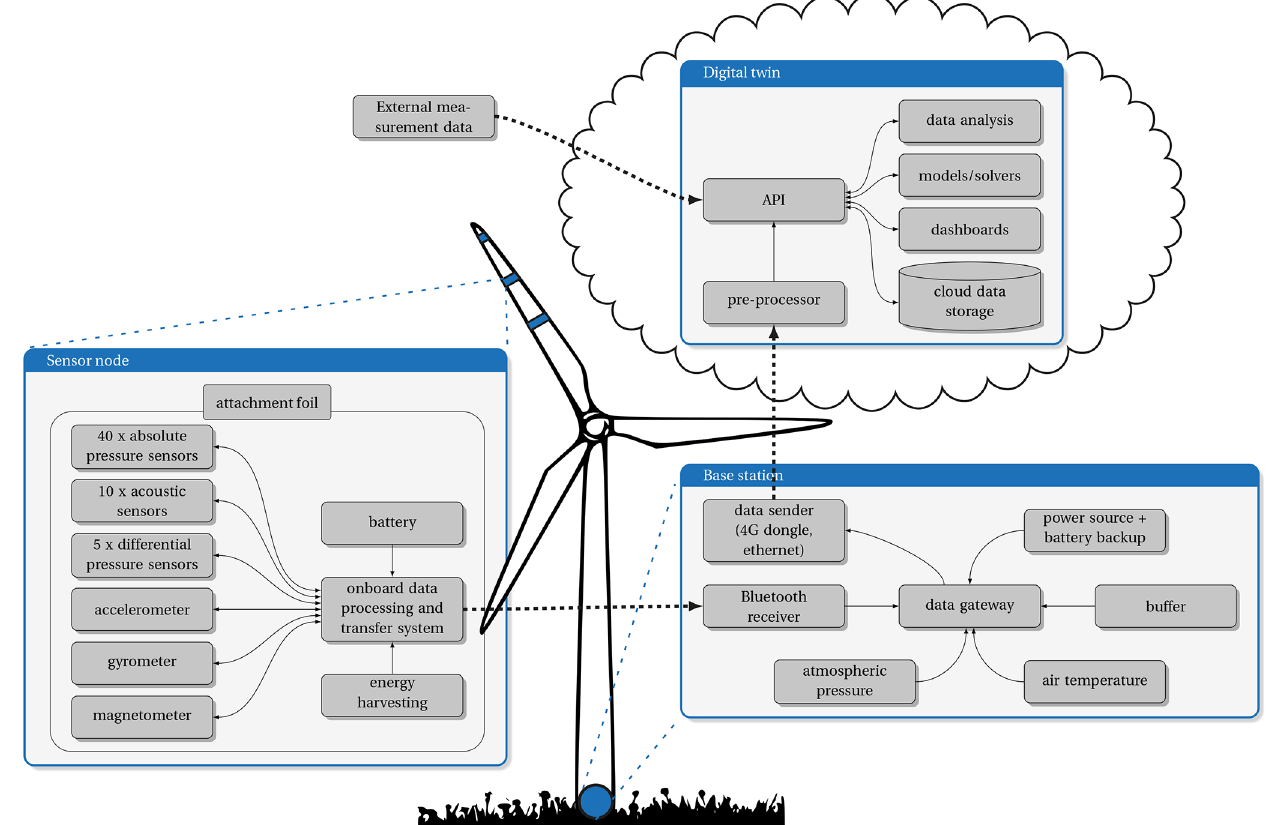
Figure 3. Overview of the Aerosense